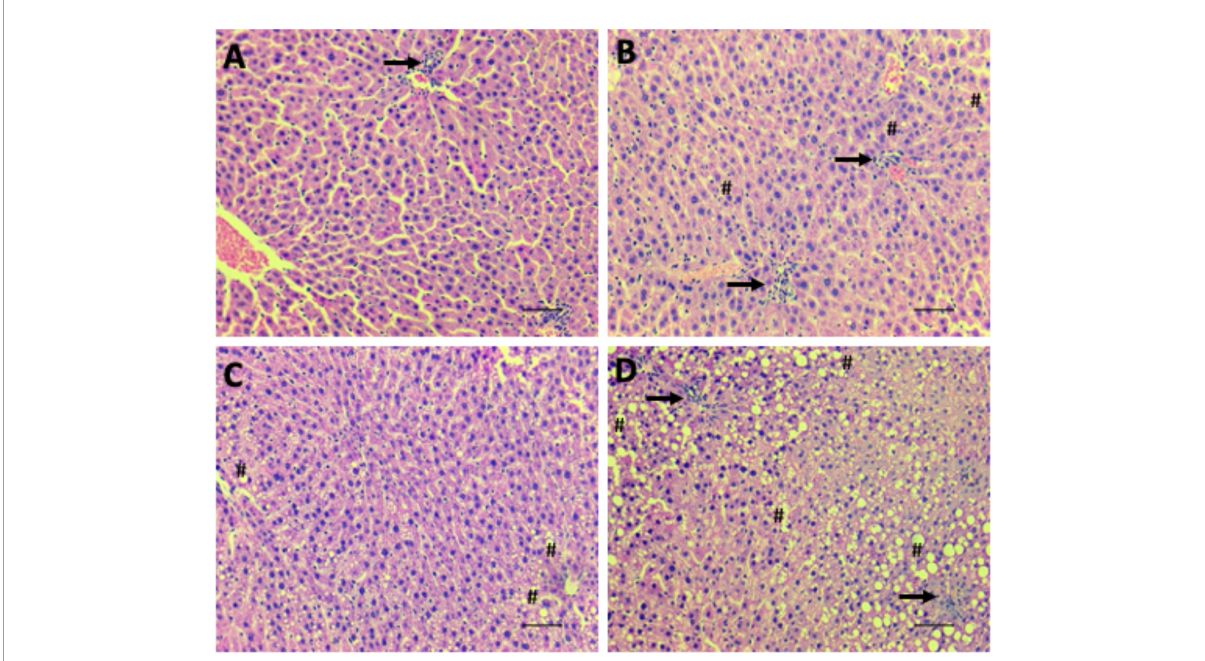
FIGURE6 Hepatic steatosis. Representative images of microscopical analyses of steatosis grade 0 (none to 5% of hepatocytes affected) ( A ; NPNF-F2), grade 1 ( > 5%–33% affected) ( B ; LPNF-F2), grade 2 ( > 33%–66% affected) ( C ; NPHF-F2) and grade 3 ( > 66% affected) ( D ; LPHF-F2). Hematoxylin and Eosin-stained sections. Hash, examples of macrovesicular steatosis, in all hepatocytes, fat inclusions displaced nucleus to the periphery; Arrow, cluster of inflammatory cells. Magnification: 200 × . Scale bar = 50 µ